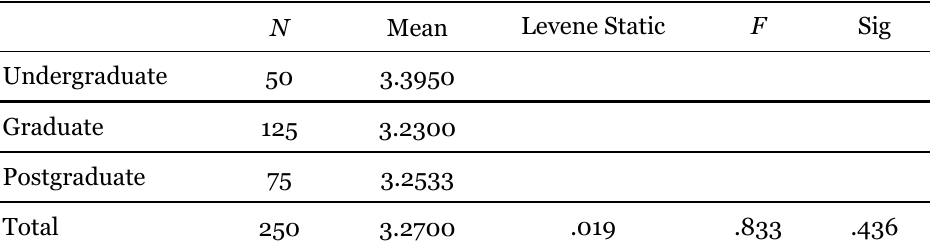
Intention to use M-Learning and Program Enrolled